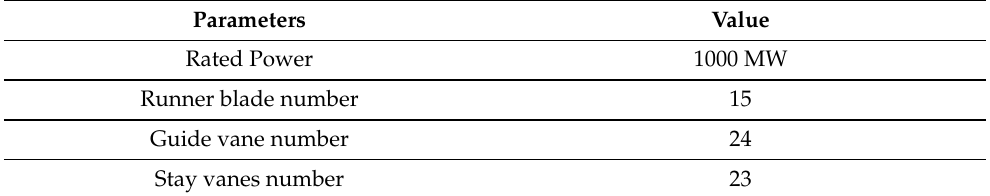
Figure 1. Flow domain model of a high-quality 1000 MW Francis turbine unit. Table 1. The unit parameters of the high-quality 1000 MW Francis